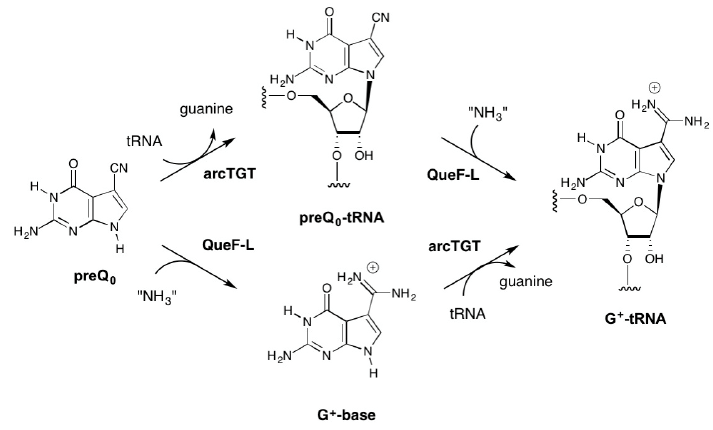
Figure 2. Possible routes to G + ‐ tRNA in Crenarchaeota possessing QueF ‐ like (QueF ‐ L) enzymes. The top pathway is analogous to the known pathway in Euryarchaeota that utilizes ArcS to carry out the amidation of preQ 0 ‐ modified tRNA. The bottom pathway is analogous to the known reaction of bacterial QueF, which carries out the four ‐ electron reduction of the nitrile group in preQ 0 to give the aminomethyl product preQ 1 .